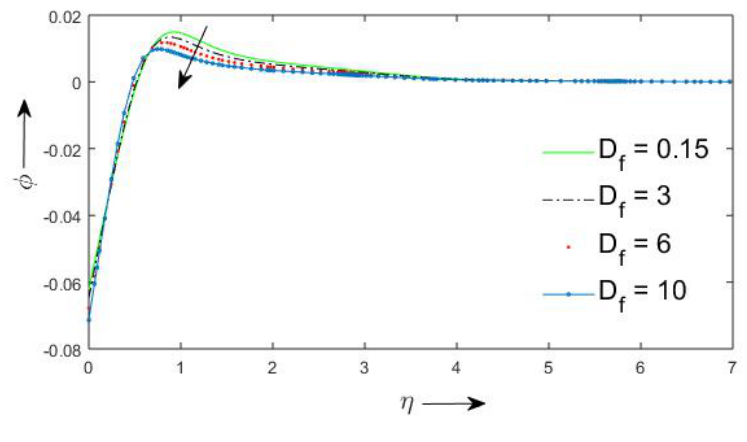
Figure 7: Distribution concentration due to D